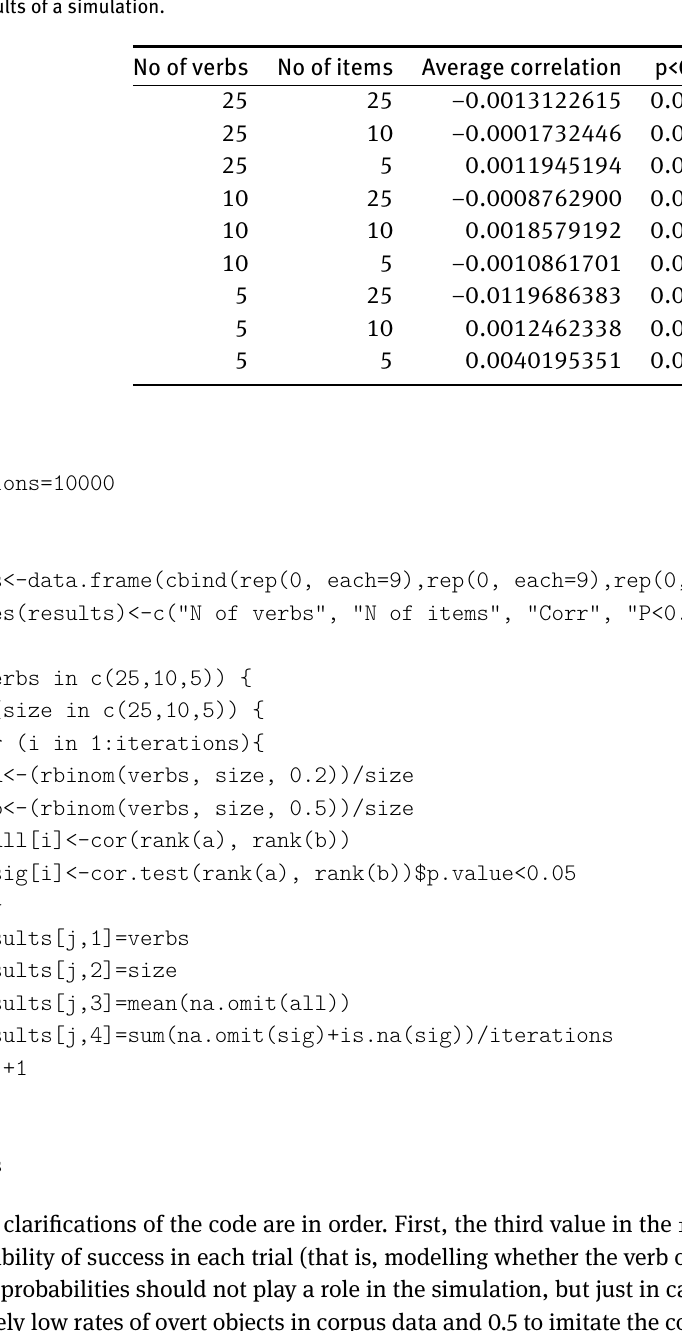
Table A1: Results of a